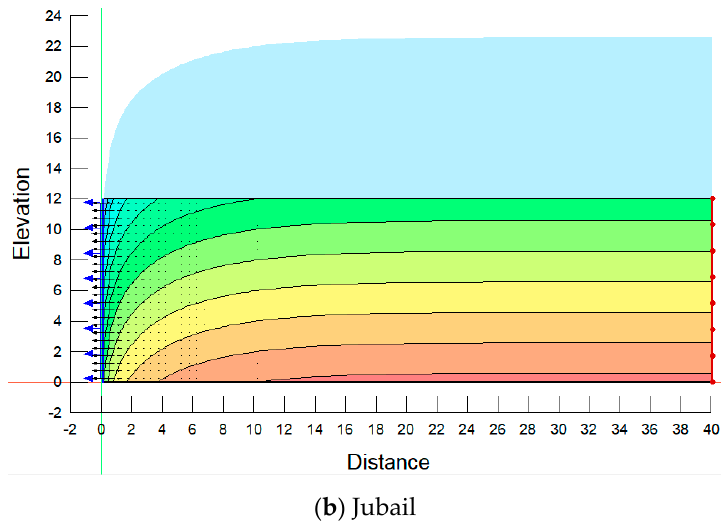
Figure 13. Contour lines for the drawdown curves for the ( a ) Al-Khobar and ( b ) Jubail sites (based on water flux leading the drawdown curve to reach 12 m).